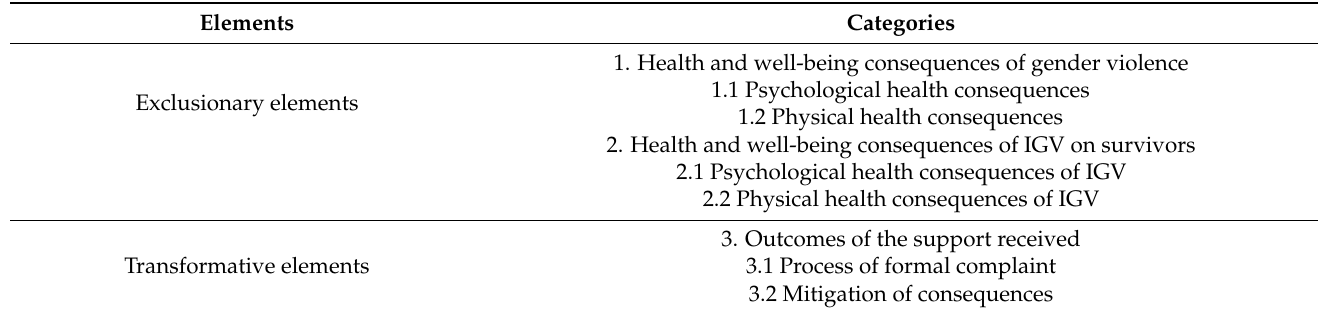
Table 1. Summary of the elements and the categories related to